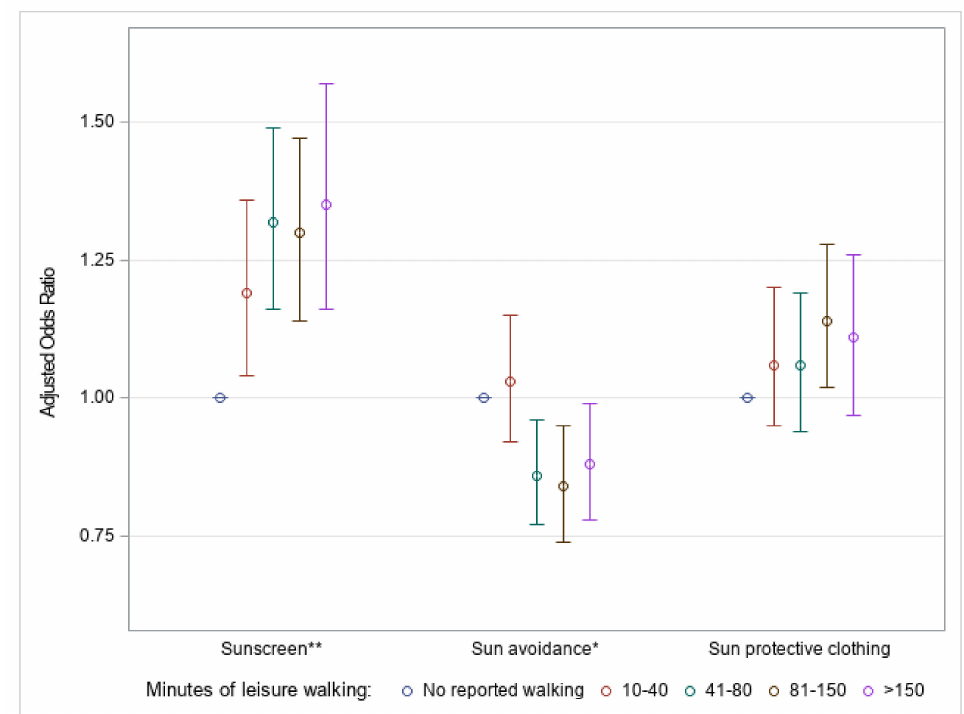
Figure 4. Weighted a adjusted b odds ratios for sun protective behaviors c by quartile of weekly leisure walking minutes for U.S. adults aged ≥ 18 years, National Health Interview Survey, 2015. (** p < 0.0001; * p = 0.0008. a 95% confidence interval; reference: No reported walking ( < 10 min of weekly leisure walking). b Covariates: Gender, age, ethnicity, education, marital status, foreign-born status,